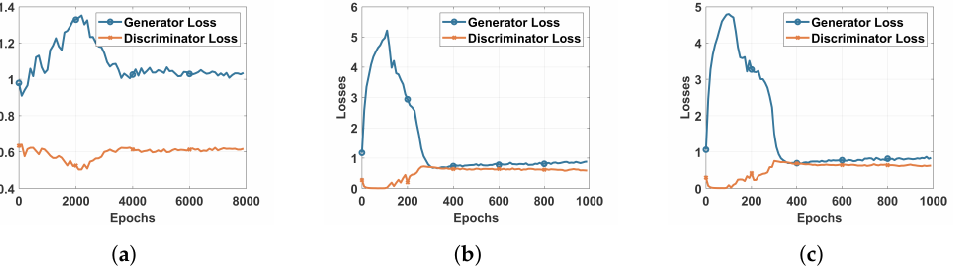
Figure 7. Losses of the Generator and Discriminator: ( a ) GAN 1 trained on full dataset ( b ) GAN 2 trained on WS class ( c ) GAN 3 trained on DP class.